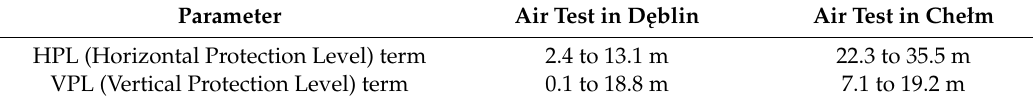
Figure 7. The HPL and VPL values of the air test in Chełm. Table 4. Comparison of integrity of aircraft position in air tests in D˛eblin and Chełm.